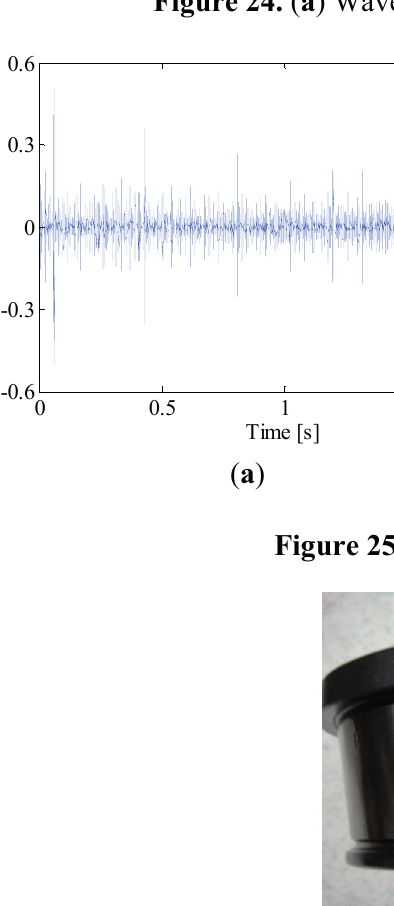
Figure 24. ( a ) Waveform and ( b ) envelope order spectrum of IMF1.